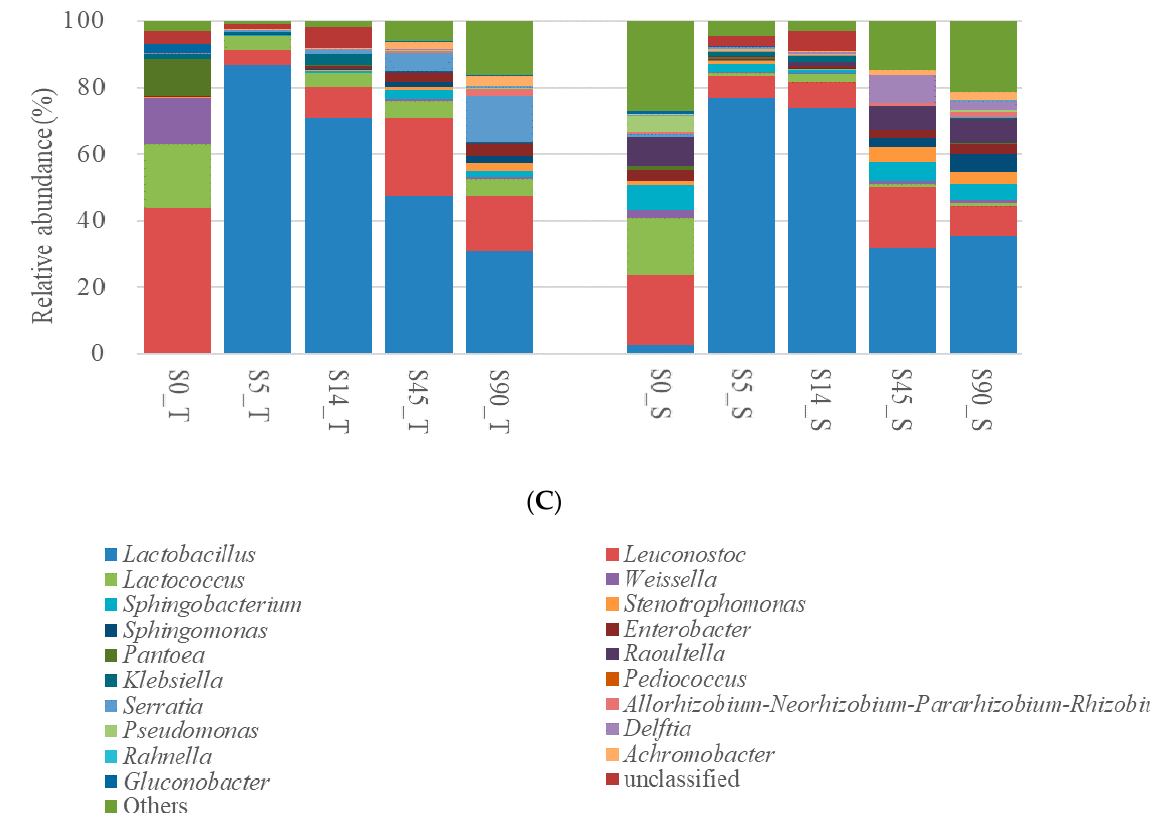
Figure 3. Relative abundance of bacterial communities (genus level) in whole-plant corn silage from ( A ) Heilongjiang, ( B ) Inner Mongolia and ( C ) Shanxi at 0, 5, 14, 45 and 90 days after ensiling ( n = 3). Whole-plant corn silages were processed at 6 locations in 3 areas of North China: Heilongjiang province (Daqing city (H_D; 124°43 ′ 42.074 ″ E, 46°18 ′ 32.083 ″ N) and Longjiang county (H_L; 123°7 ′ 32.120 ″ E, 47°21 ′ 23.396 ″ N), cold and wet agricultural area), Inner Mongolia Autonomous Region (Helin county (I_H; 111°36 ′ 21.625 ″ E, 40°28 ′ 47.672 ″ N) and Tumet Left Banner (I_T; 111°9 ′ 31.399 ″ E, 40°41 ′ 29.832 ″ N), temperate and dry pastoral area) and Shanxi province (Taigu (S_T; 112°37 ′ 53.792 ″ E, 37°25 ′ 57.230 ″ N) and Shanyin (S_S; 112°52 ′ 06.676 ″ E, 39°32 ′ 54.503 ″ N) counties, temperate and dry agricultural area).